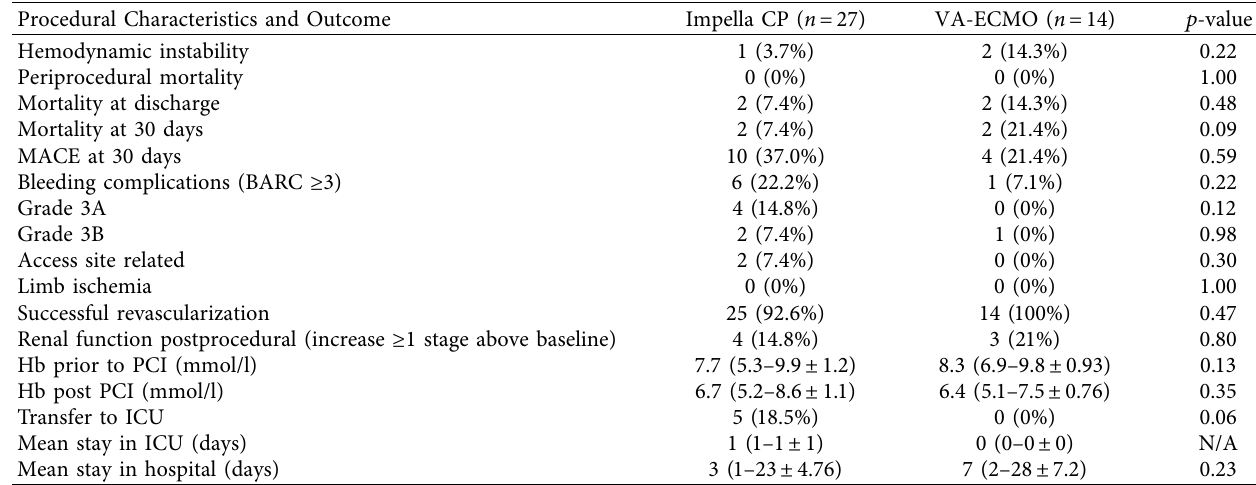
Table 3: Procedural characteristics and outcome.